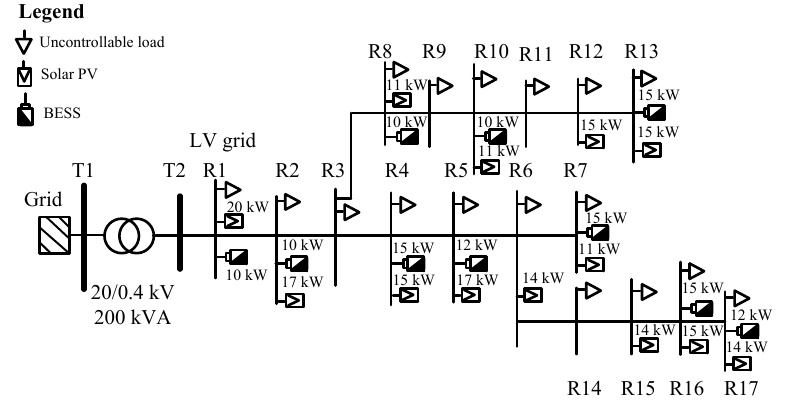
Figure 3. Schematic diagram of LV distribution grid used for simulation studies [13]. A typical daily profile of PV power generation and load consumption with 10 min